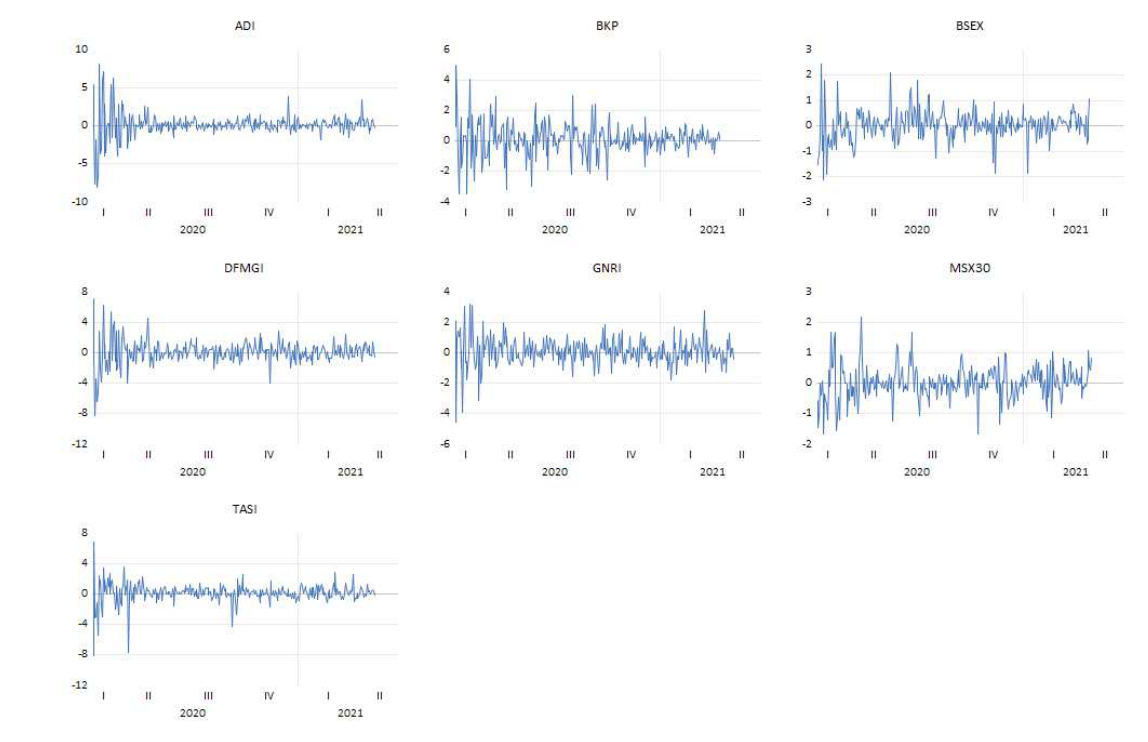
Figure 1. Volatility in GCC stock market return index